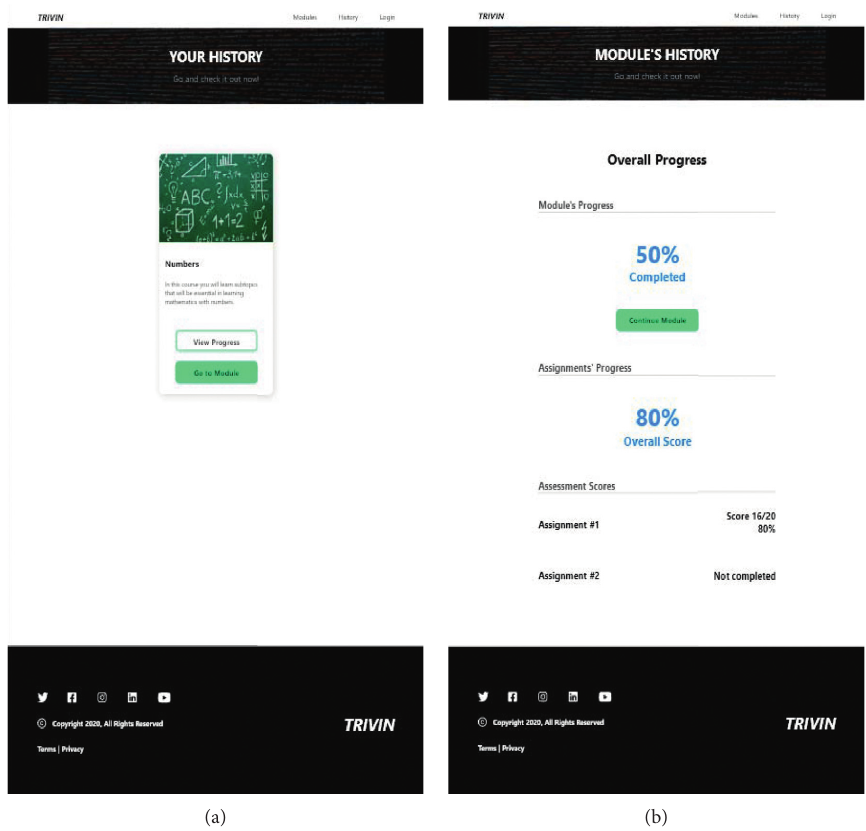
Figure 7: (a) History page UI and (b) view progress page